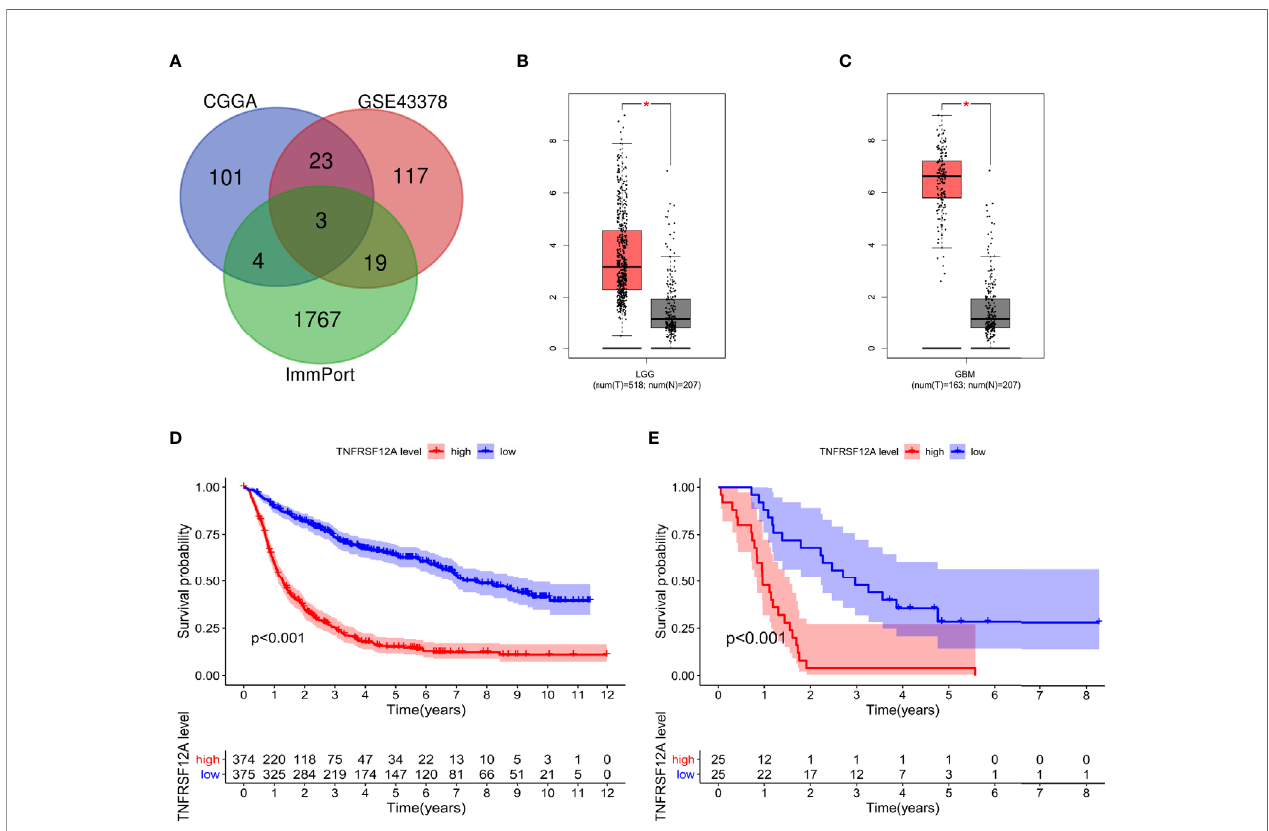
FIGURE 2 | (A) Venn diagram identifying the intersection of glioma prognostic genes from CGGA and GSE43378 data and immune genes from ImmPort. (B) Expression of TNFRSF12A in LGG and normal samples. (C) Expression of TNFRSF12A in GBM and normal samples. (D) Survival analysis of glioma patients in the high and low expression groups of TNFRSF12A in CGGA. (E) Survival analysis of glioma patients in the high and low expression groups of TNFRSF12A in GSE43378. * p <